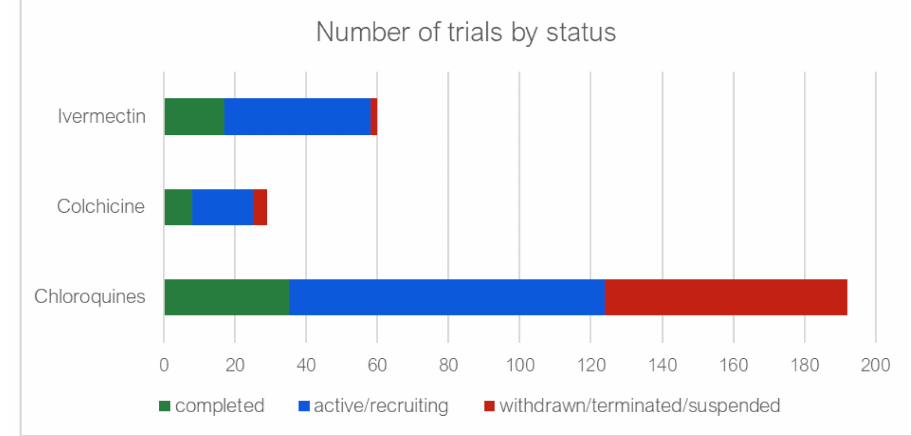
Figure 8. Number of clinical trials completed, still active and either withdrawn, suspended or